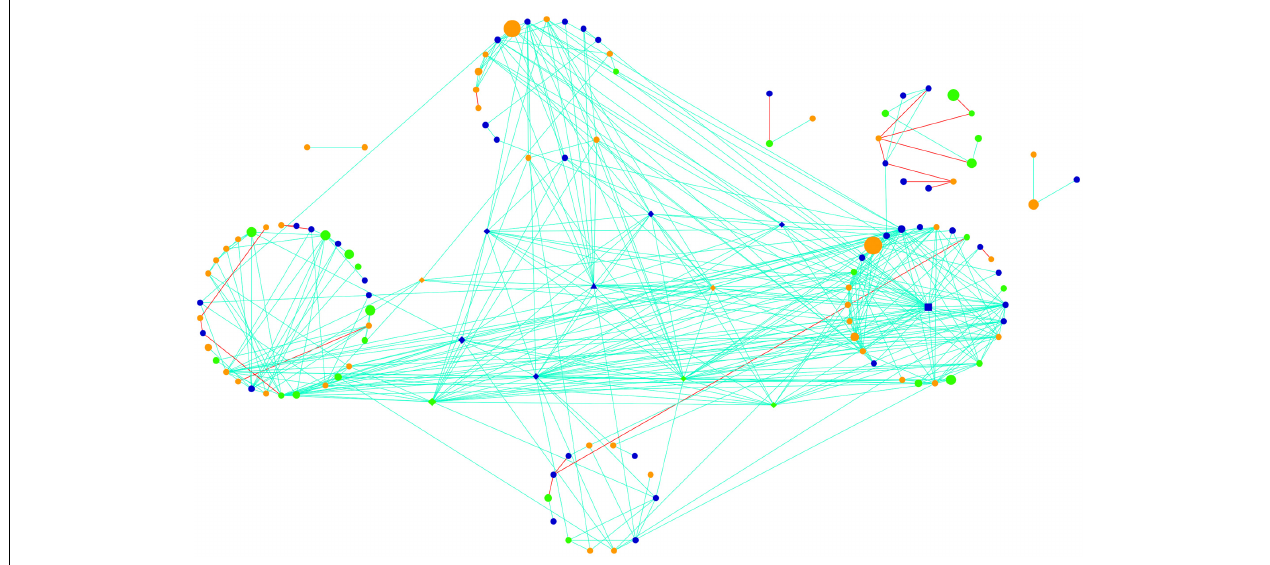
FIGURE 4 | Global potentially active network comprising hypolithic community members at the genus level. Nodes represent Cyanobacteria (green), Proteobacteria (dark blue), and heterotrophic bacteria (orange). Lines connecting nodes (edges) are significant ( P < 0.05) positive (light blue) or negative (red) relationships. Node size is proportional to the number of reads assigned to the taxon. Network hubs are triangles, module hubs are squares, connectors are shown as diamonds, and peripherals are indicated by circles.